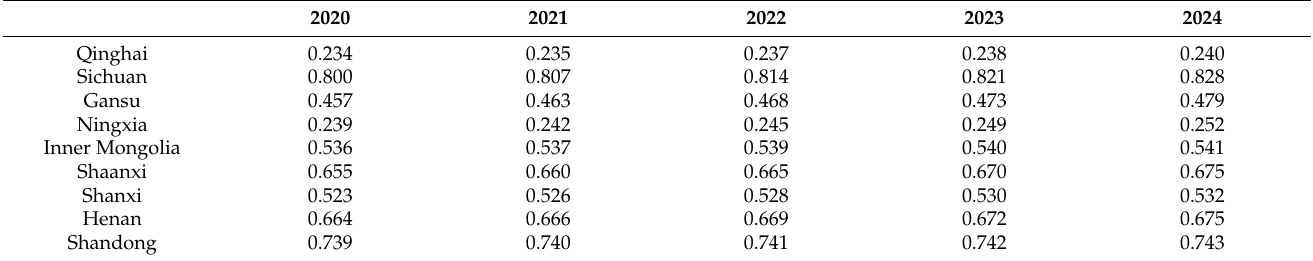
Table 6. Prediction of coordinated development of tourism-ecological environment-public service coupling in provinces along the Yellow River